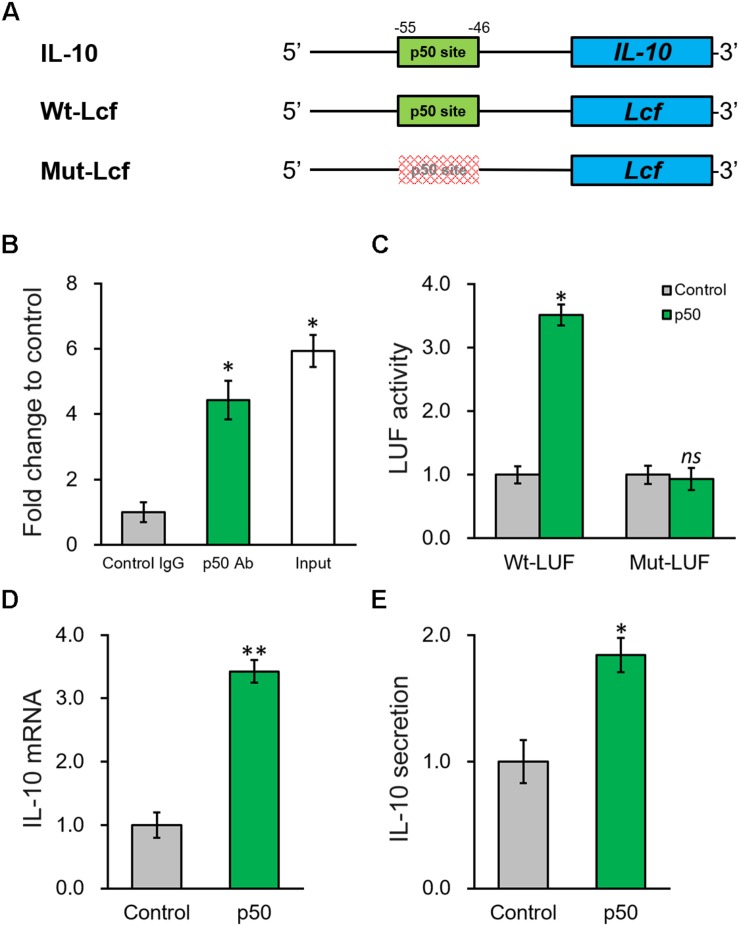
NF-κB p50 subunit induces IL-10 expression by directly binding to its promoter region. (A) The putative p50 binding site was identified in the promoter region of IL-10. Wild type (Wt-LUF) and mutated (Mut-LUF) sequences from IL-10 promoter were cloned, respectively, to the 5′-prime of luciferase reporter gene (LUF). (B) Binding of p50 to the putative binding site in IL-10 promoter were analyzed by ChIP assay using control IgG and p50 antibody (Ab), respectively. (C) Luciferase activities of Wt-LUF or Mut-LUF constructs described in (A) were measured in BMSCs transfected with control vector or p50, respectively. (D,E) Levels of IL-10 mRNA with representative gel images of PCR products shown below the bar graph (D), and in media (E) were examined in BMSCs transfected with control vector or p50, respectively. Values are mean ±SD at least three independent biological repeats in triplicates. ∗∗P < 0.01, ∗P < 0.05, ns, not significant, vs. respective control.